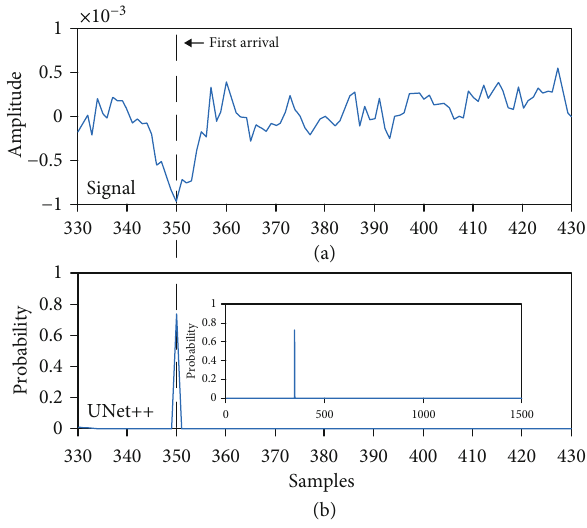
Figure 10: First-arrival picking result of the forward modeling signal with -3-dB Gaussian noise added. (a) Local ampli fi cation of the signal in the range from 330ms to 430 ms. (b) The picking result in the range from 330ms to 430 ms obtained by the UNet++.